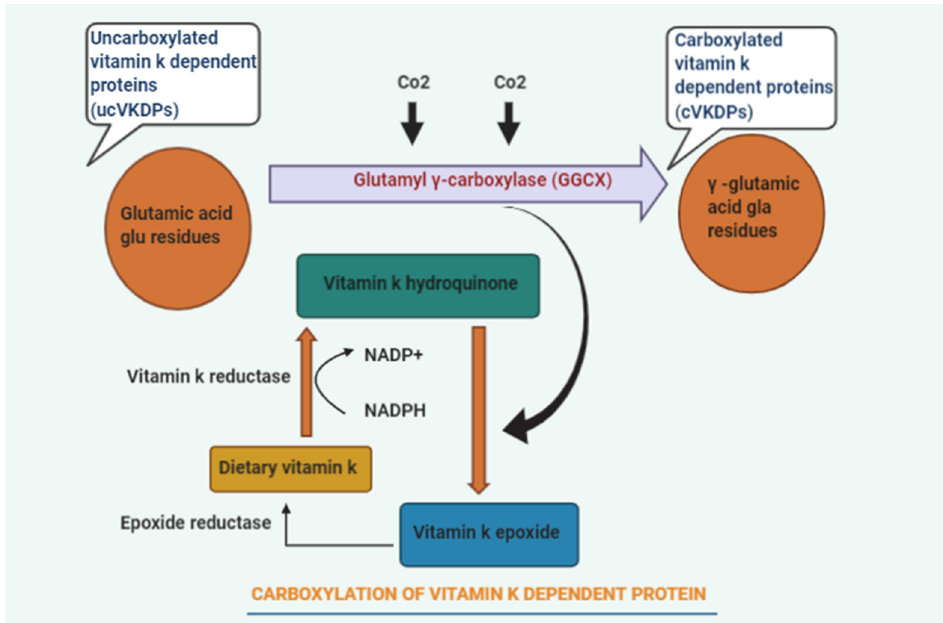
Figure 1. Diagrammatic representation of Vitamin K (VK) dependent protein